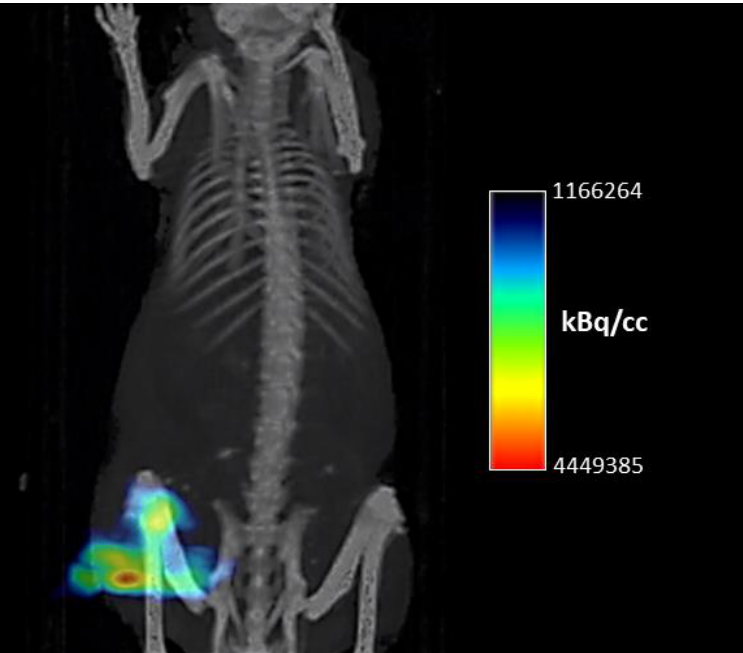
Figure 6. Representative static small animal SPECT/CT image 3-h after the intratumoral injection of 2.04 MBq of 198 AuNP in the PC-3 tumor bearing Balb/c nude mouse. The image is displayed as the maximum intensity projection.